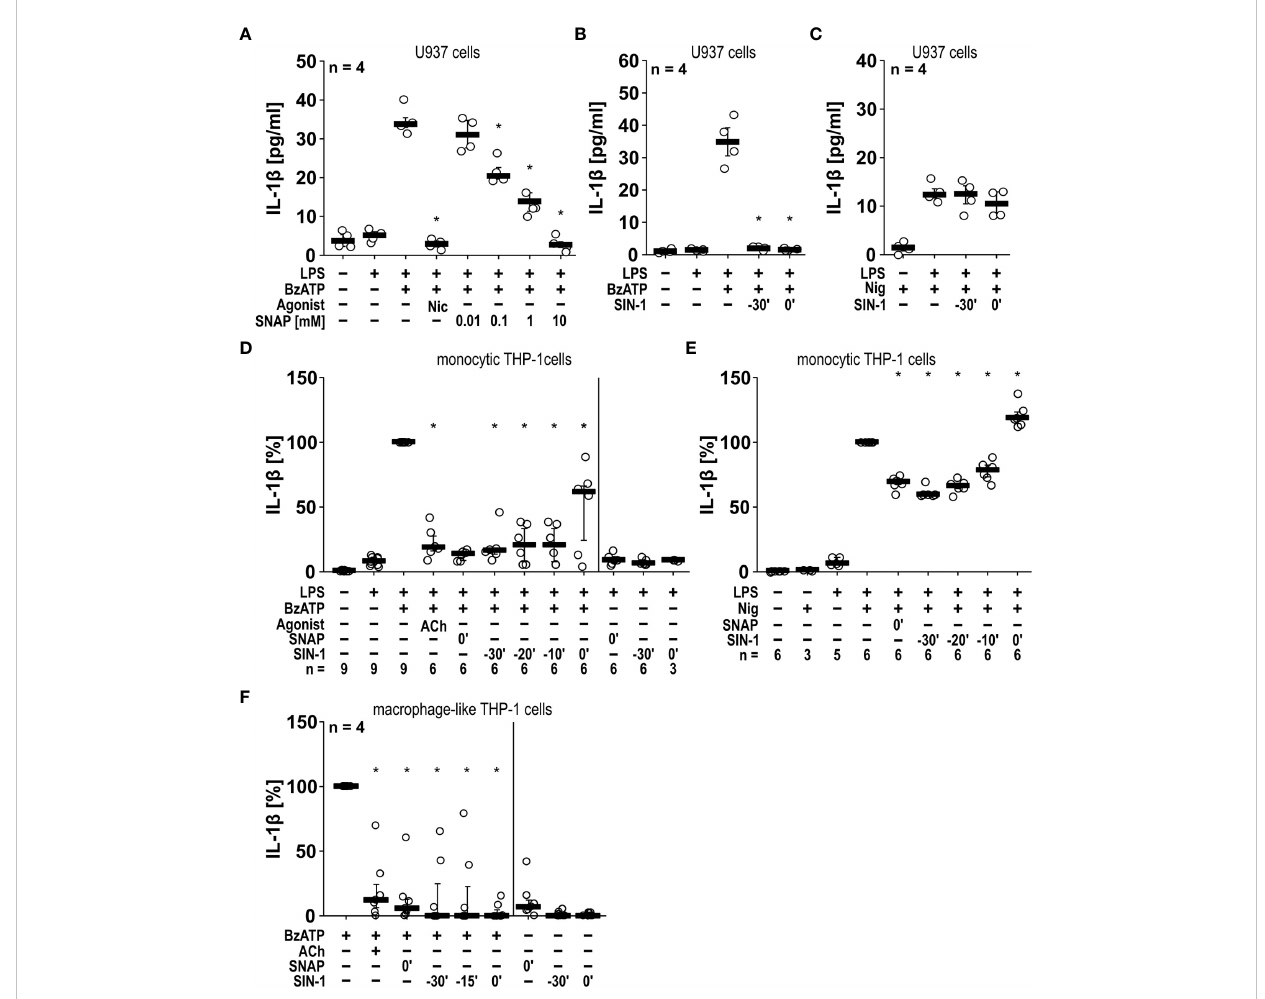
FIGURE 4 The BzATP-induced release of IL-1 b by monocytic and macrophage-like cells is inhibited by the NO donors SNAP and SIN-1. (A, B) Monocytic U937 cells were primed with lipopolysaccharide (LPS; 1 µg/ml) for 5 h, and BzATP ((2 ’ /3 ’ -O-(4-benzoylbenzoyl)adenosine-5 ’ -triphosphate, tri (triethylammonium) salt; 100 µM) was added for another 30 min to trigger IL-1 b release, which was measured by ELISA. The NO donor SNAP (S- nitroso-N-acetyl-DL-penicillamine) concentration-dependently inhibited the BzATP-induced release of IL-1 b like nicotine (Nic; 100 µM),